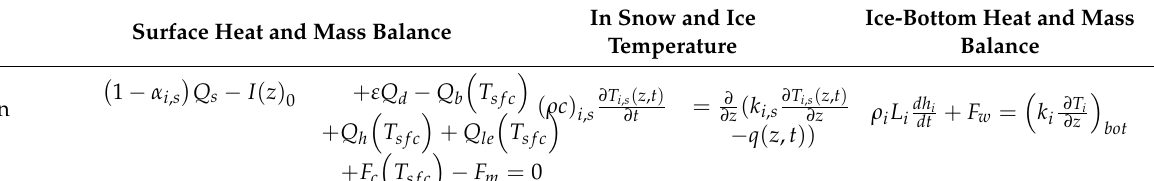
In Snow and Ice Temperature